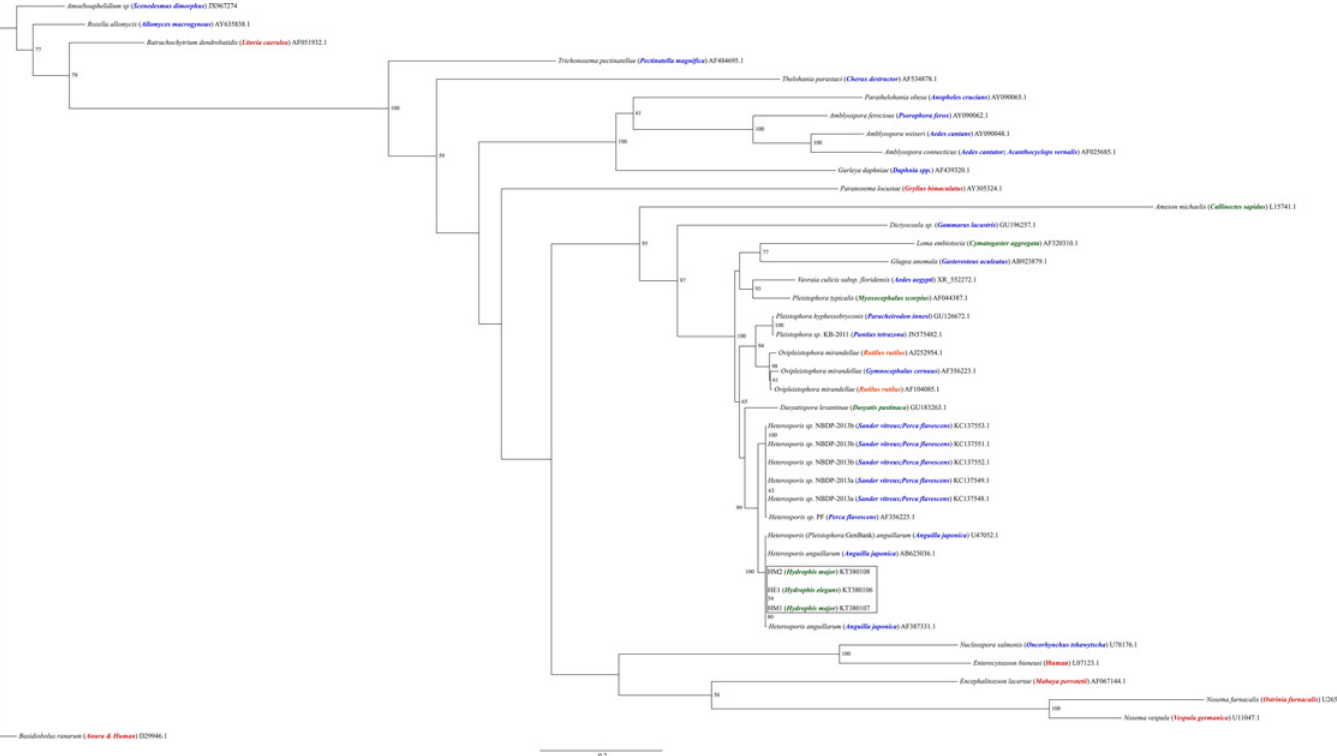
Fig 4. Maximum likelihood analysis of the relationships of sea snake microsporidia (HM1, HM2 and HE1) and representatives of each major microsporidian group based on the ssrRNA gene. Phylogenetic tree constructed using PhyML from 41 sequences using TIM3 + G + I substitution model. Bootstrap values are listed as percentages generated from 1000 iterations. Bootstrap values were expressed as percentages and only values above 50 are shown. GenBank accession numbers are listed after species and host species names. Host species are denoted in parentheses. Color denotes predominant host habitat type (Red; terrestrial, Green; marine, Blue; freshwater, Orange; brackish). Scale bar indicates the number of nucleotide substitutions per site.